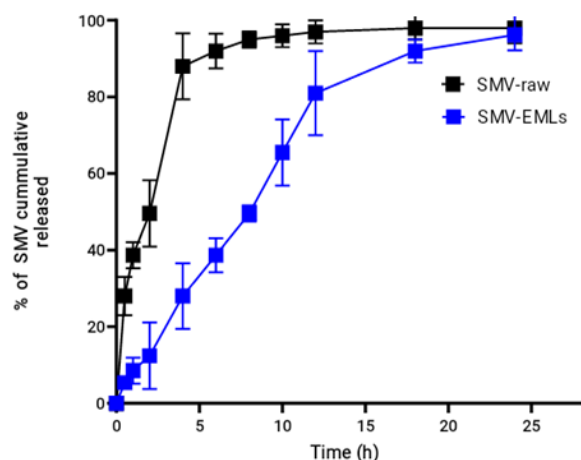
Figure 5. In vitro release profile of optimized SMV-EMLs in PBS (pH 7.4) containing Tween 80 (0.1%) at 37 ± 0.5 °C.